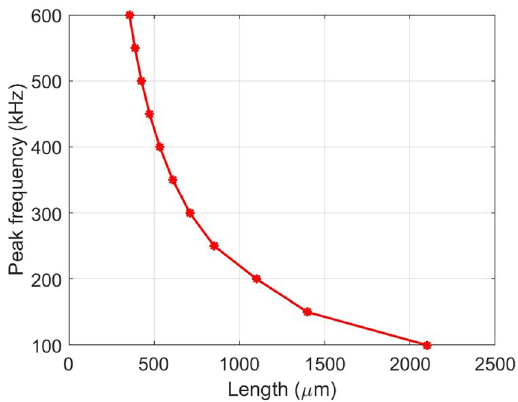
Figure 5: The particle length corresponding to vibration frequencies.